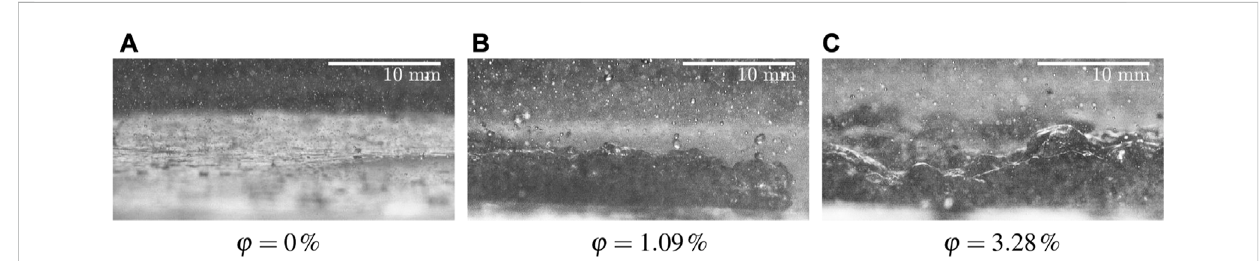
FIGURE 7 Shadowgraphyvisualizationsofobservedphenomenafor φ =0%(distilledwater), φ =1.09%and φ =3.28%.Thesprayparametersare:themeandrop diameter D 10 = 78.7 μ m, the mean impact velocity U = 14.05 m/s and the mass fl ux _ m (cid:1) 2 . 50 ± 0 . 03 kg/m 2 s. Initial wall temperature was T w0 = 445 ° C. Snapshots were taken at surface temperature T = 280 ° C. (A) distilled water, (B) 1.09% lubricant solutions and (C) 3.28% lubricant